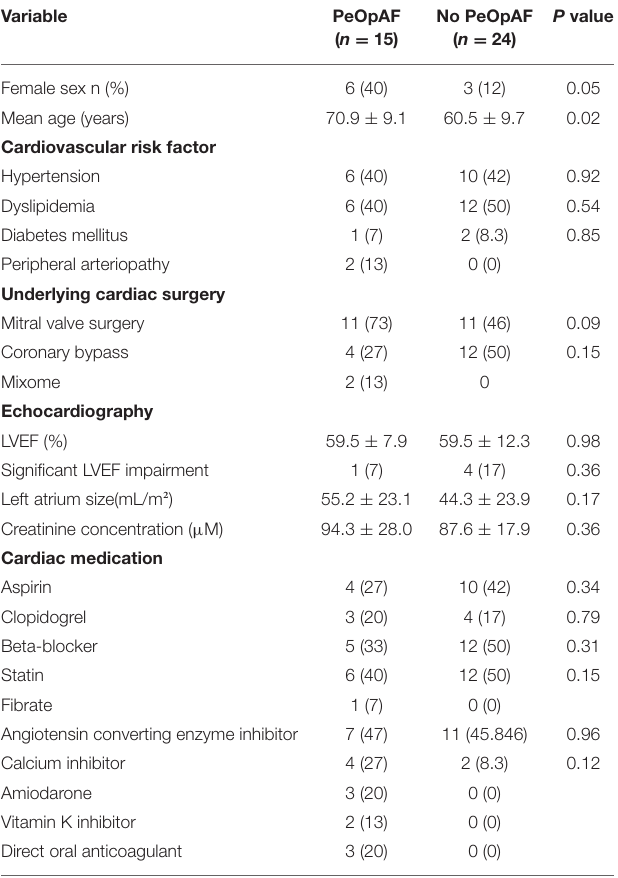
TABLE 1 | Demographic characteristics of patients undergoing cardiac surgery. Variable